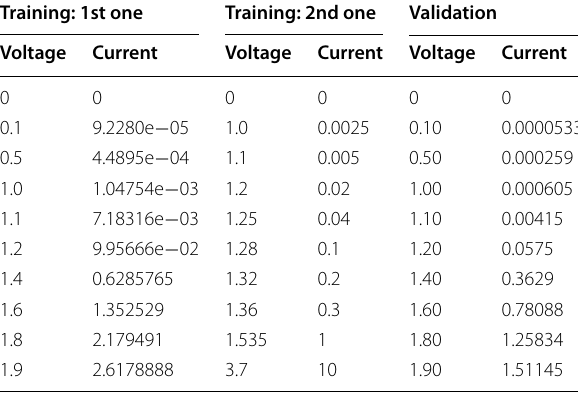
Table 6 Magnetization curves of training samples